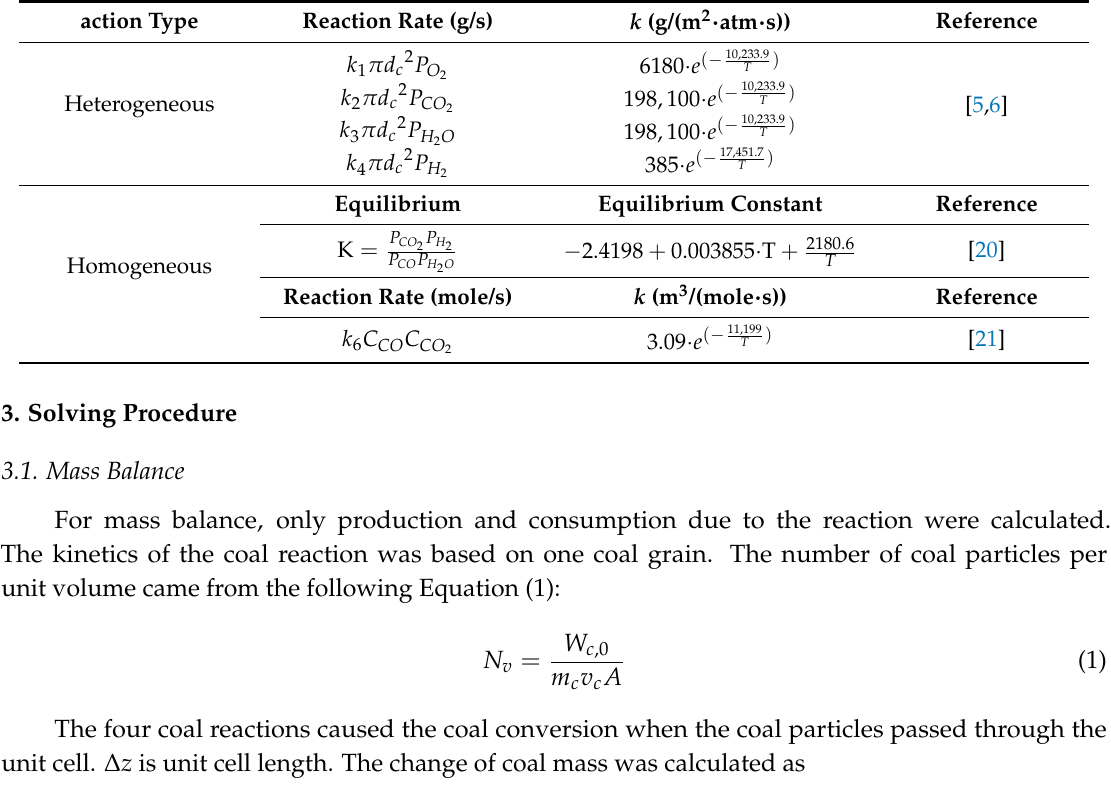
Table 3. Reaction kinetics and parameters that were used in this